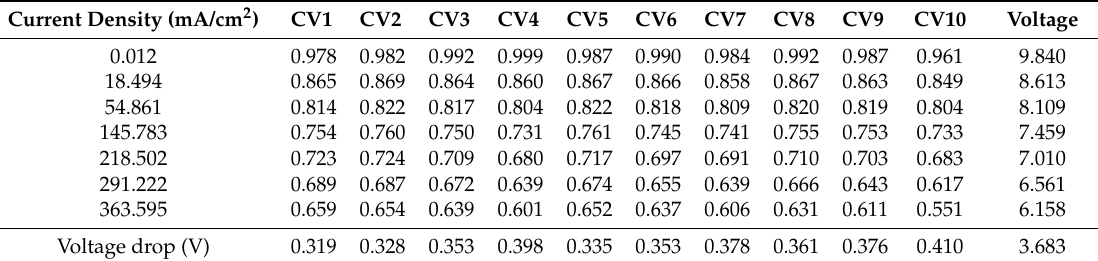
Table 3. Dynamic performance at different relative humidities (55%).